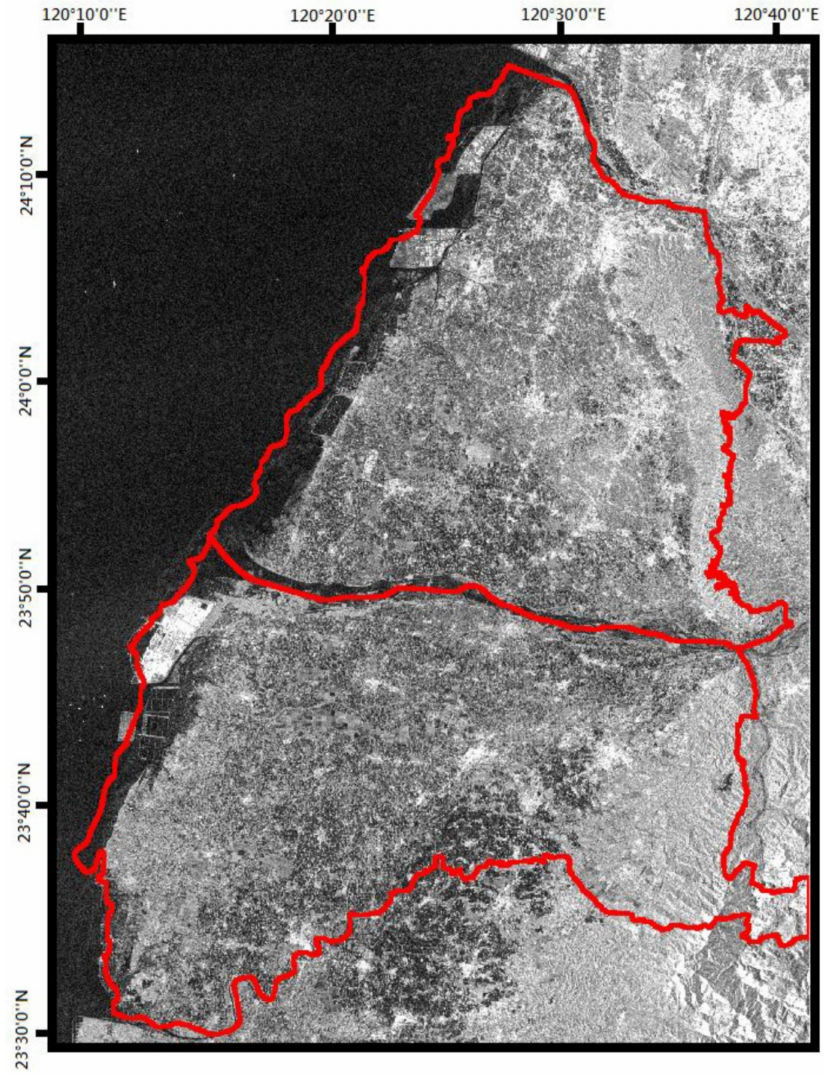
Figure 1. The study area consists of Yunlin and Changhua counties in central Taiwan. The red border represents the boundary of the study area. Background data received from Sentinel-1A on 8 February